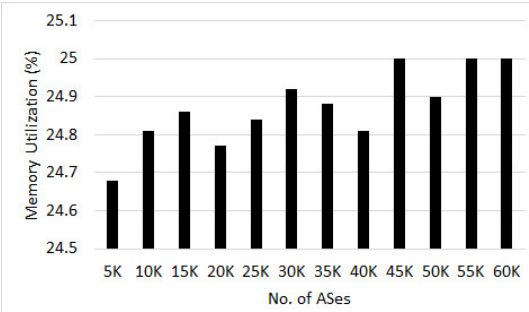
Figure 16. Avg. memory usage